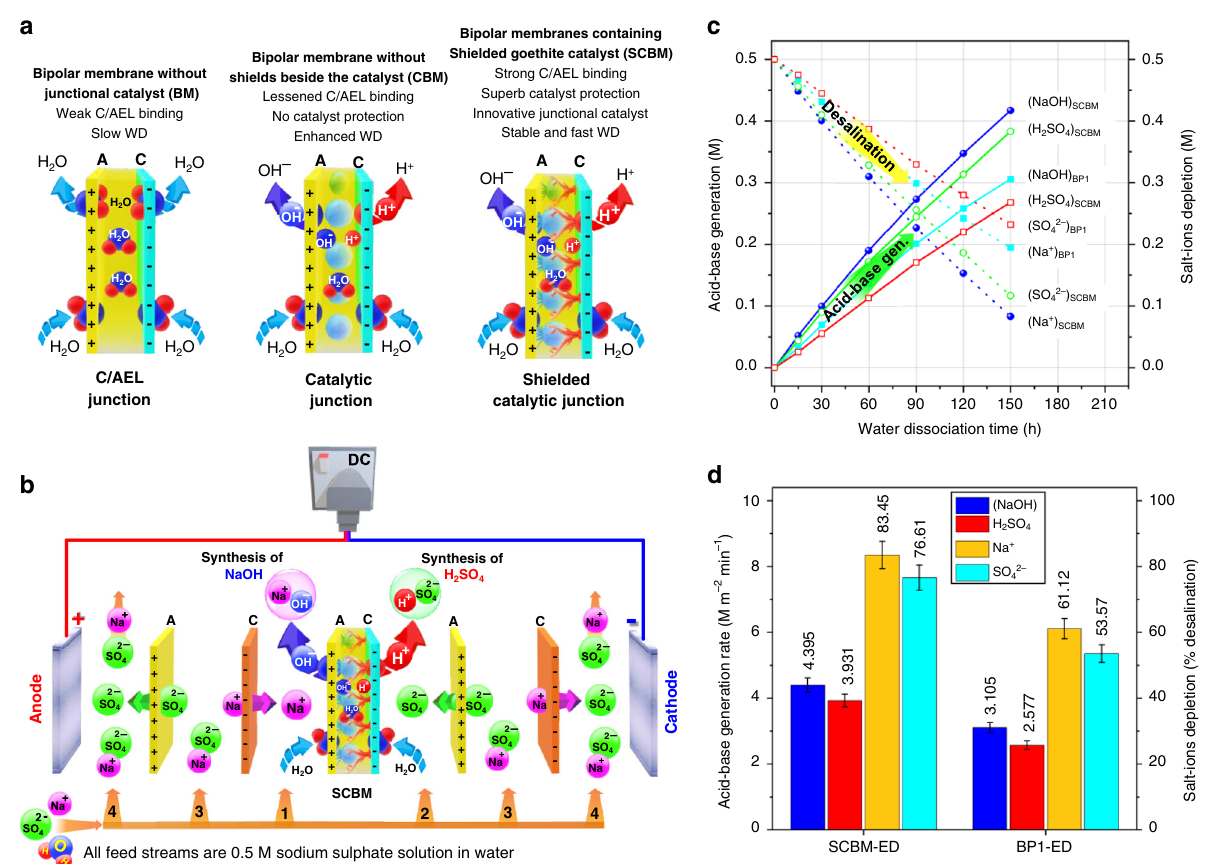
Fig. 6 SCBMs-ED approves fast in-situ acid – base generations and saline-water desalination. a Simplistic models exhibiting the excellent role of junctional catalyst and polyaniline shields. b The SCBMs-integrated electrodialysis single-cell, comprising SCBMs at the centre, surrounded by two sets of commercial anion – cation exchange membranes (Neosepta ® AMX and CMX, denoted here as A and C, respectively). The arrangement of cell plates develops four types of compartments: 1-base, 2-acid, 3-auxiliary and 4-electrode rinsing solution, sequentially from the centre of the cell towards the electrodes. Notably, AEL surface of the SCBMs (7.07 cm 2 effective area) is orientated facing the anode compartment. Four batches of 200 ml 0.5 M Na 2 SO 4 salt solution were separately supplied and continuously circulated within each type of the compartment. The water continuously diffuses inside the SCJ, wherein the catalyst dissociates the feedwater and C/AEL withdraw the resulting H + /OH − ions under applied reverse-bias DC potential for an in-situ acid-base generation. c The acid-base generation and saline-water desalination performance with ED time and d the acid – base generation rate and percentage saline-water desalination (within data variation of ±5% s.d.) indicating the signi fi cantly better performance of the SCBMs than the commercial BP1